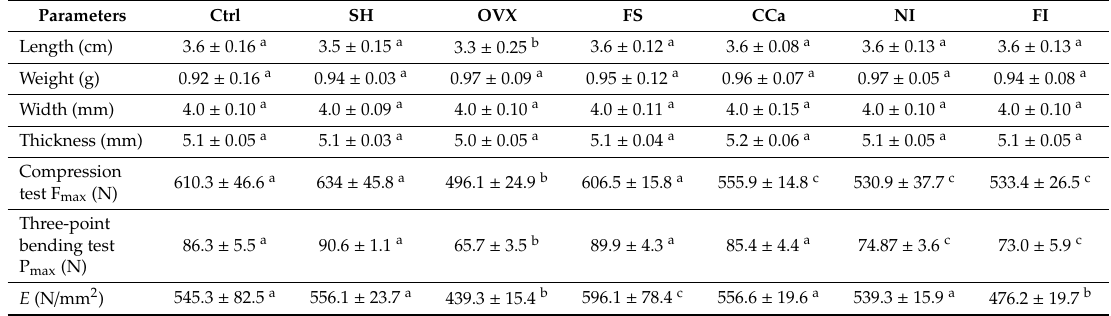
The values represent mean ± SD, n = 5 rats / group. Means in rows with di ff erent letters di ff er significantly ( p ≤ 0.05). F max : failure load evaluated by the compression test, P max : failure load evaluated by the three-point bending test. Ctrl = control group, SH = sham group, OVX = ovariectomized group fed with AIN-93M, FS = ovariectomized group fed with diet supplemented with soluble fiber extracted from O. ficus-indica , CCa = ovariectomized group fed with diet supplemented with calcium citrate, NI = ovariectomized group fed with diet supplemented